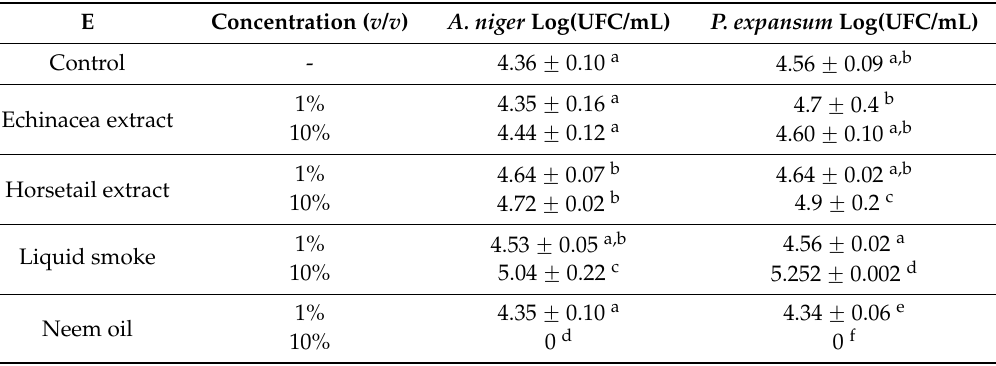
Table 1. Viable counts of Aspergillus niger and Penicillium expansum after 24 h in contact with the different plant extracts (E) in PDB at 25 ˝ C.